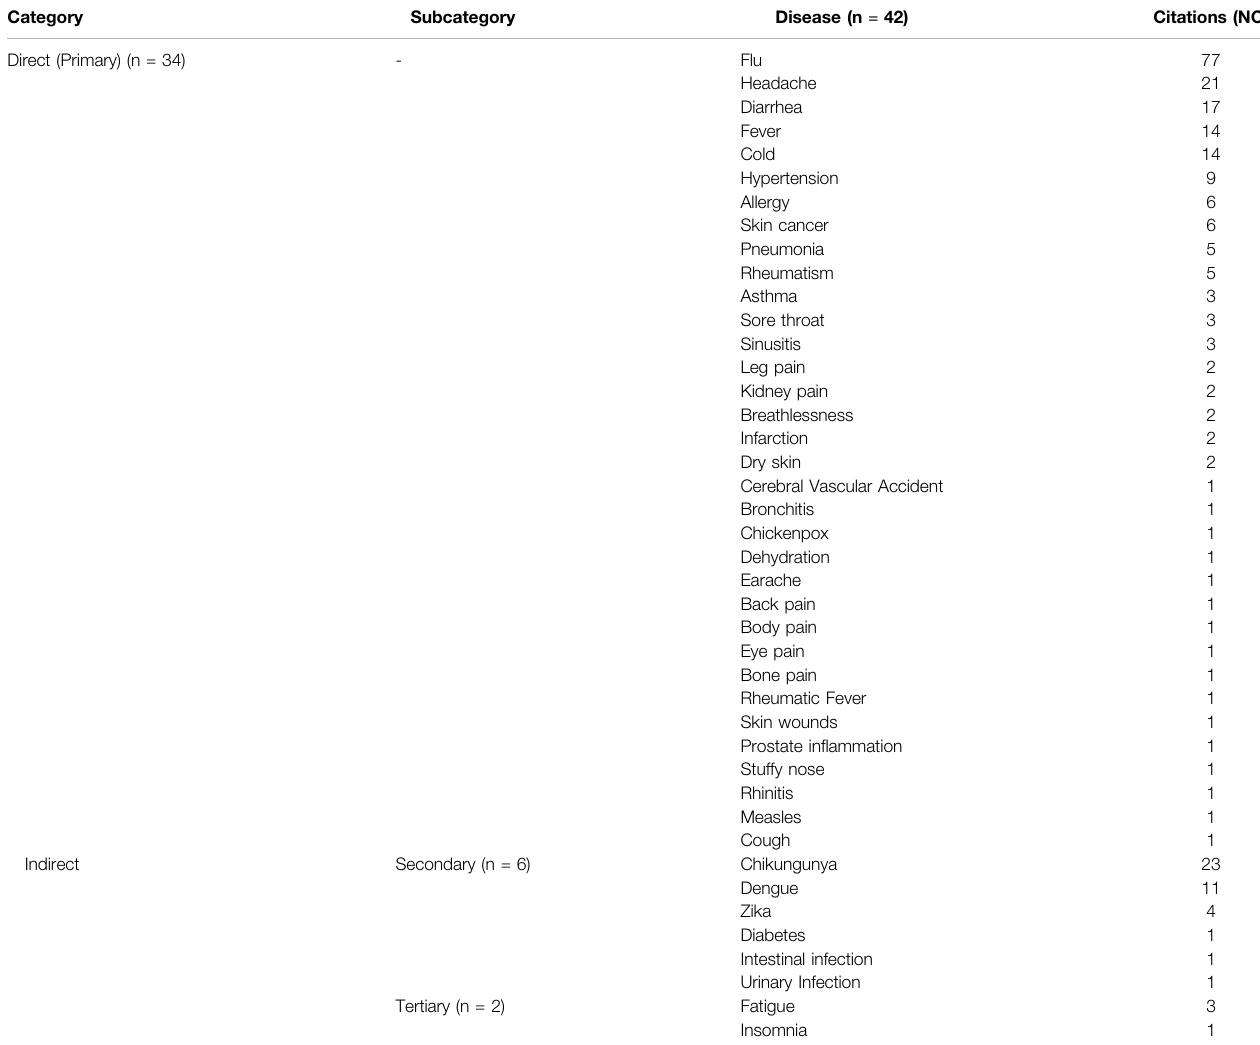
TABLE 2 | Climate change-related diseases perceived by small-scale farmers living in the Catimbau NAPAR, Pernambuco State, Northeastern Brazil.